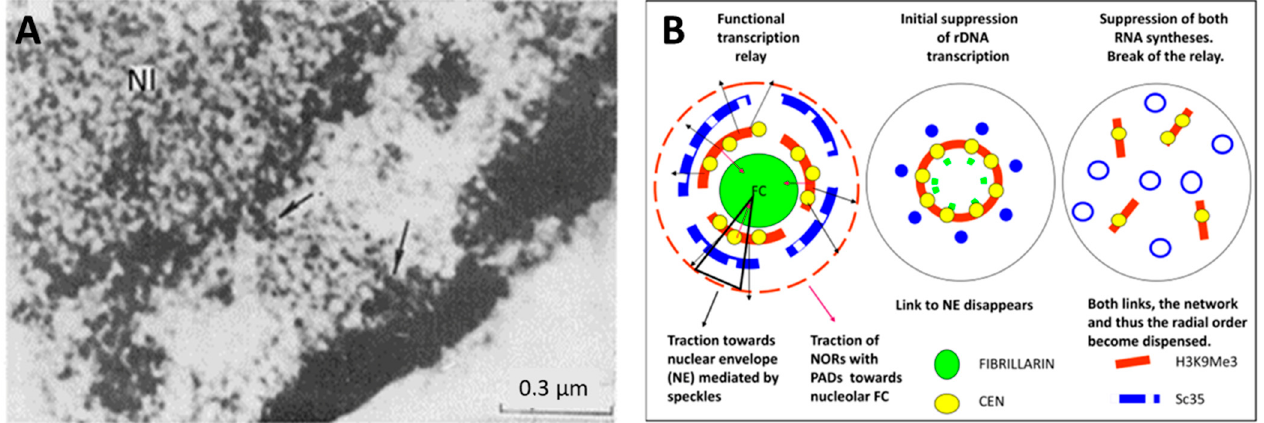
Figure 14. Speckles acting as radial spring pumps anchored between the nucleolar and perinuclear flexibly rigid heterochromatin shells and equipped by elastic actomyosin elements integrate the radial-concentric nuclear order for transcription pulsing. ( A ) Thin EM section of rat ascitic Zajdela hepatoma cells. The links of the speckle to the perinucleolar and perinuclear heterochromatin (arrows), Nl—nucleolus; ( B ) Schematic of the functional transcriptional relay in its relationship with speckles (SC35) and the concentric rings of the nucleolar and perinuclear heterochromatin shells (H3K9me3), deduced from experiments with suppression of RNA synthesis and the literature on the participation of the nuclear cytoskeleton in it. FC—fibrillar center, NORs—nucleolar organizers; CEN—centromeres. (Note: This figure was originally published under CC ‐ BY license in [62]).